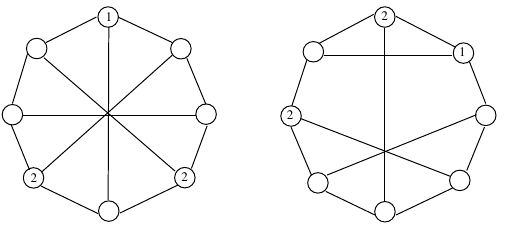
Figure 6: Two 3-regular graphs of order 8 and diameter 2.